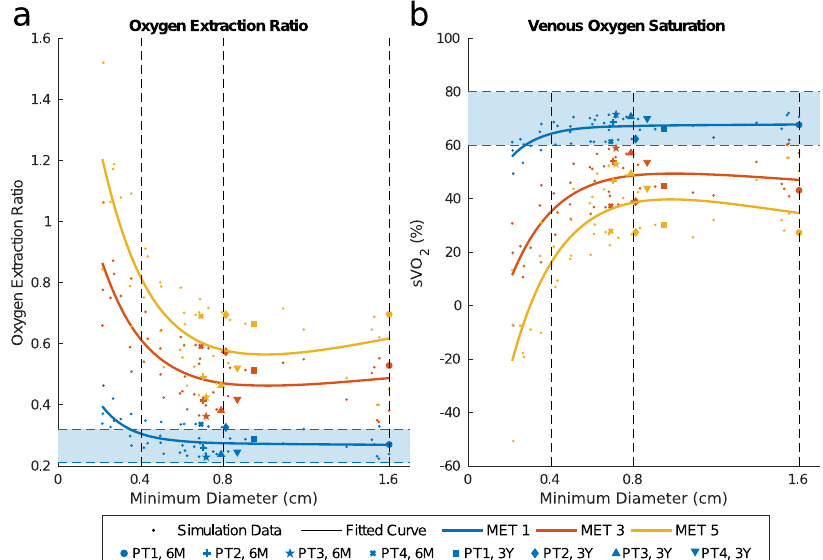
Fig. 6 Oxygenation metrics describing the performance of simulated graft geometries. a Estimated oxygen extraction ratio (OER) at MET levels with MET 1 reference values of 0.21 – 0.32 OER indicated by the shaded region. b Estimated sVO 2 at MET levels with MET 1 reference values of 60 – 80% sVO 2 indicated by the shaded